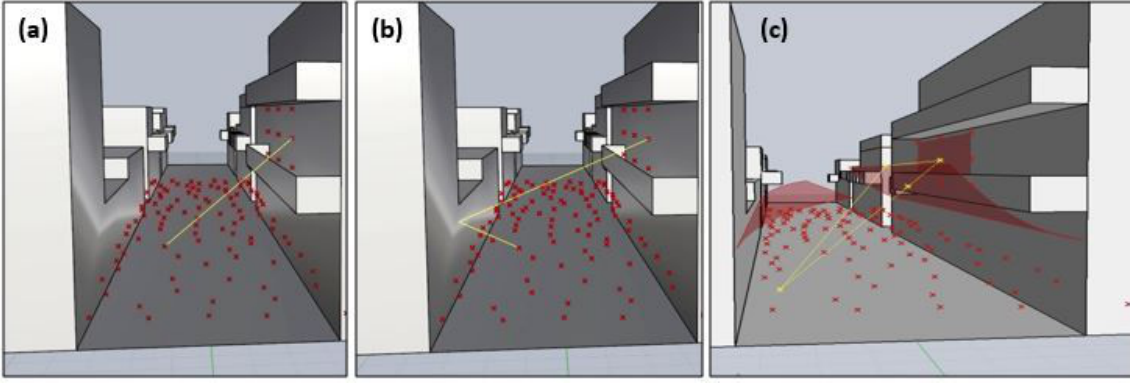
Figure 5: (a) Direct beam; (b) Reflected beam; (c) Diffraction according to